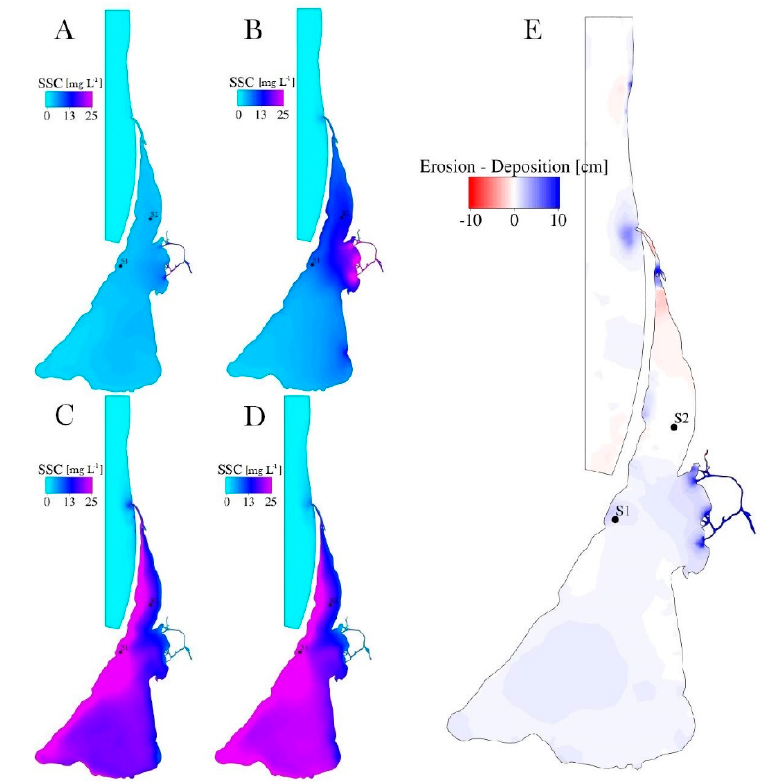
Figure 8. Seasonal distribution of SSC in the water column ( A ) winter, ( B ) spring, ( C ) summer, ( D ) autumn. ( E ) Erosion–deposition patterns after 12 years.